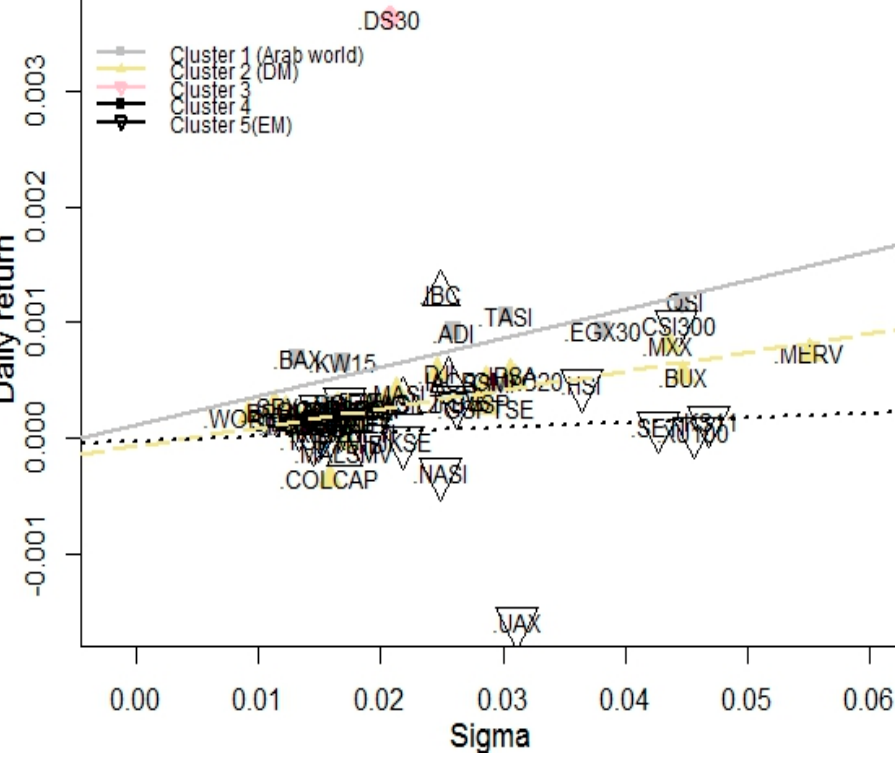
Figure 11. Five Gaussian-kernel based normalized modularity clusters.